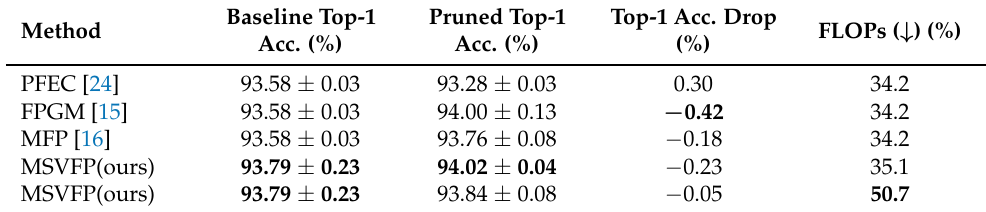
Table 2. Comparison of VGGNet pruning on the CIFAR-10